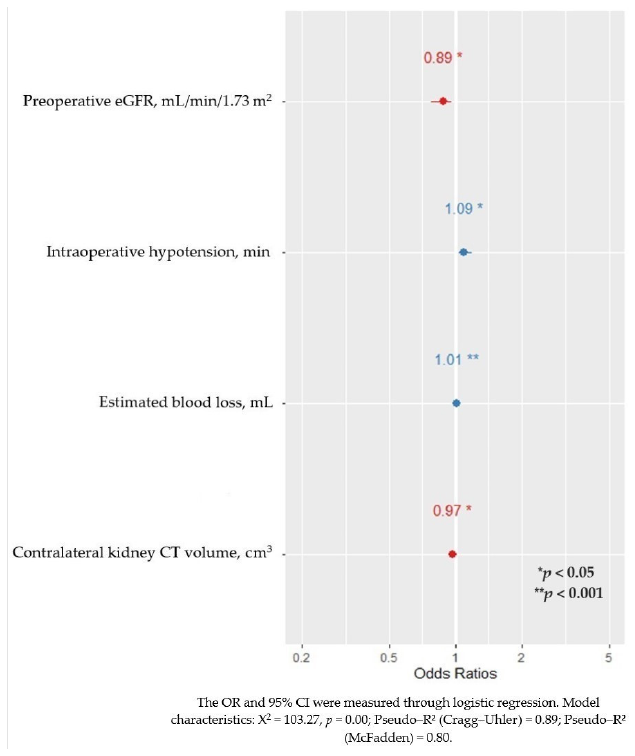
Figure 4. Risk factors of CKD 12 months after radical nephrectomy. Abbreviations: CT—computed tomography; eGFR—estimated glomerular filtration rate. The ROC analysis with sensitivity 95.6% and specificity 95.7% of this logistic regression model is shown in Figure 5.